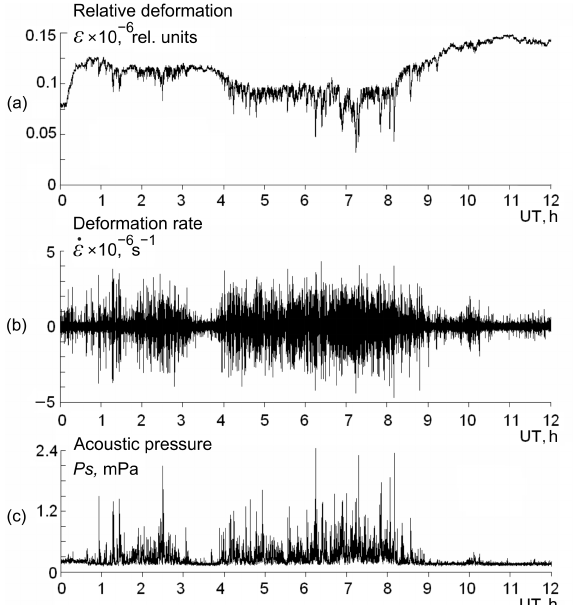
Figure 4. An example of a simultaneous acoustic-deformation anomaly before earthquake No. 1. ( a ) Variations of rock relative deformation ε , ( b ) variations of deformation rate ˙ ε , ( c ) variations of acoustic pressure P s , accumulated over 4 s in the frequency range of 2.0–6.5